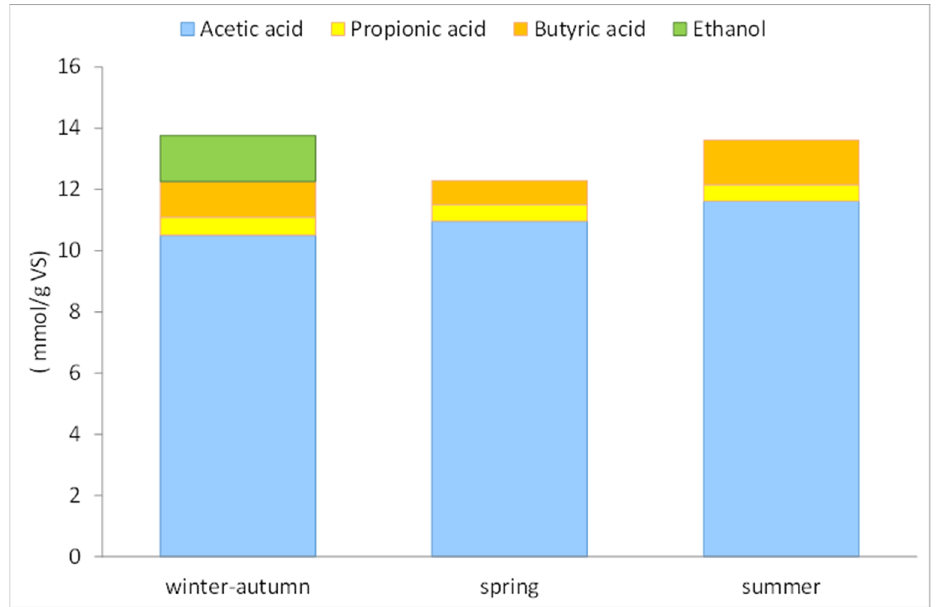
Figure 2. The yield of each end-product in the fermentate obtained from the dark fermentation of the winter/autumn, spring, and summer fruit and vegetable waste mixtures.